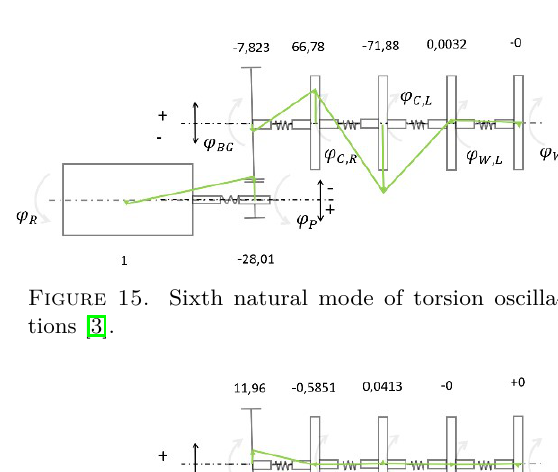
Figure 18. Natural frequencies as a function of ve- locity – c 11 .